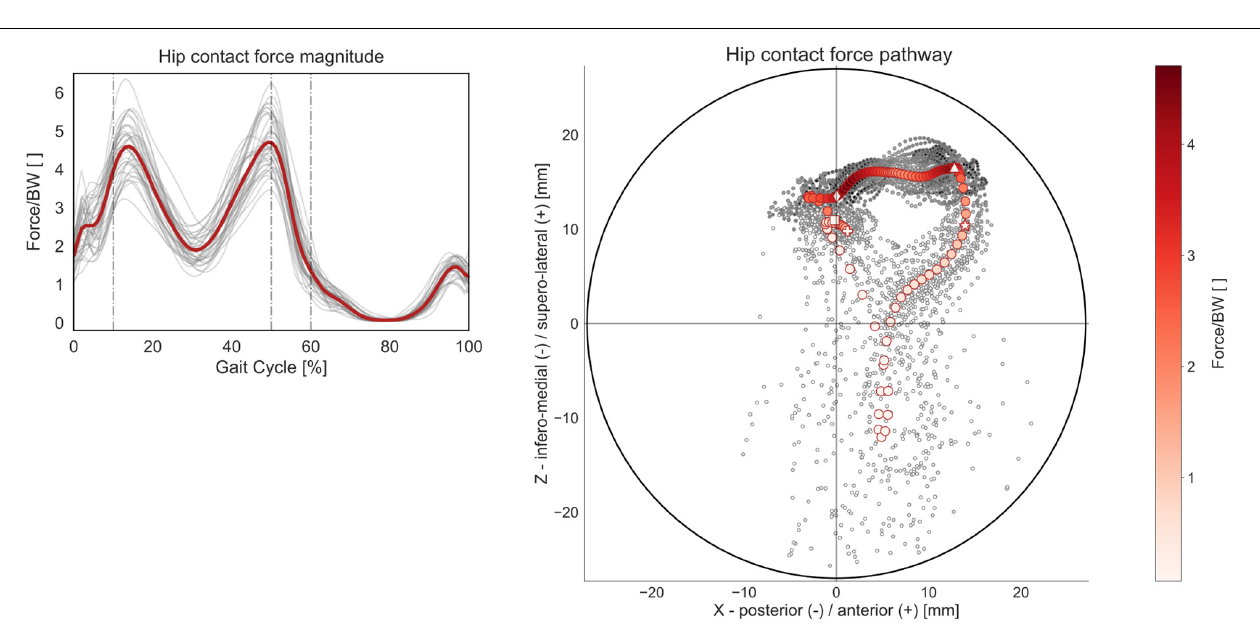
FIGURE 9 | HCF magnitude and acetabular pathway over the GC. Average profiles for each subject are reported in gray, while the cohort’s mean is reported in red. Forces are reported normalized by body weight (BW). The HCF pathway was calculated as the intersection of the HCF vector with a hemisphere fitting the acetabulum, standardized to a diameter of 54 mm. Each circular marker represents one of the 101 time points in which the GC was discretized. The initial heel strike (0% GC) is highlighted with a squared marker, the transition from initial loading response to mid-stance (10% GC) with a diamond marker, the transition from terminal stance to pre-swing (50% GC) with a triangular marker, the transition from stance to swing phase (60% GC) with a star marker, and the final heel strike (100% GC) with a cross marker.